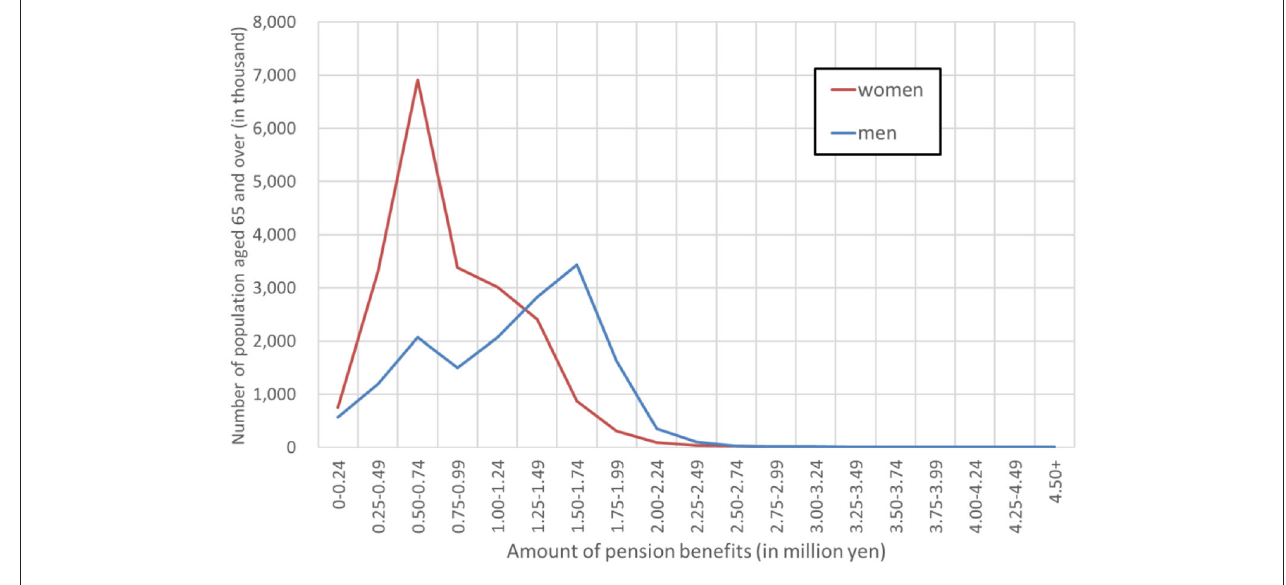
FIGURE 4 | Distribution of pension amounts by gender (2030). Simulation results.